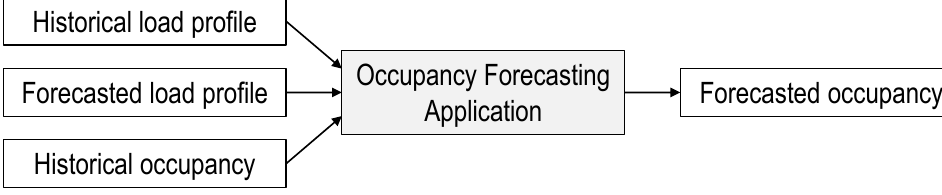
Figure 18. Block scheme of the occupancy forecasting application based on supervised